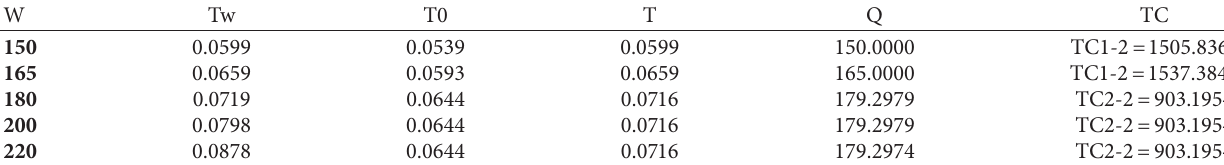
Table 2: The obtained solutions under different values of W.